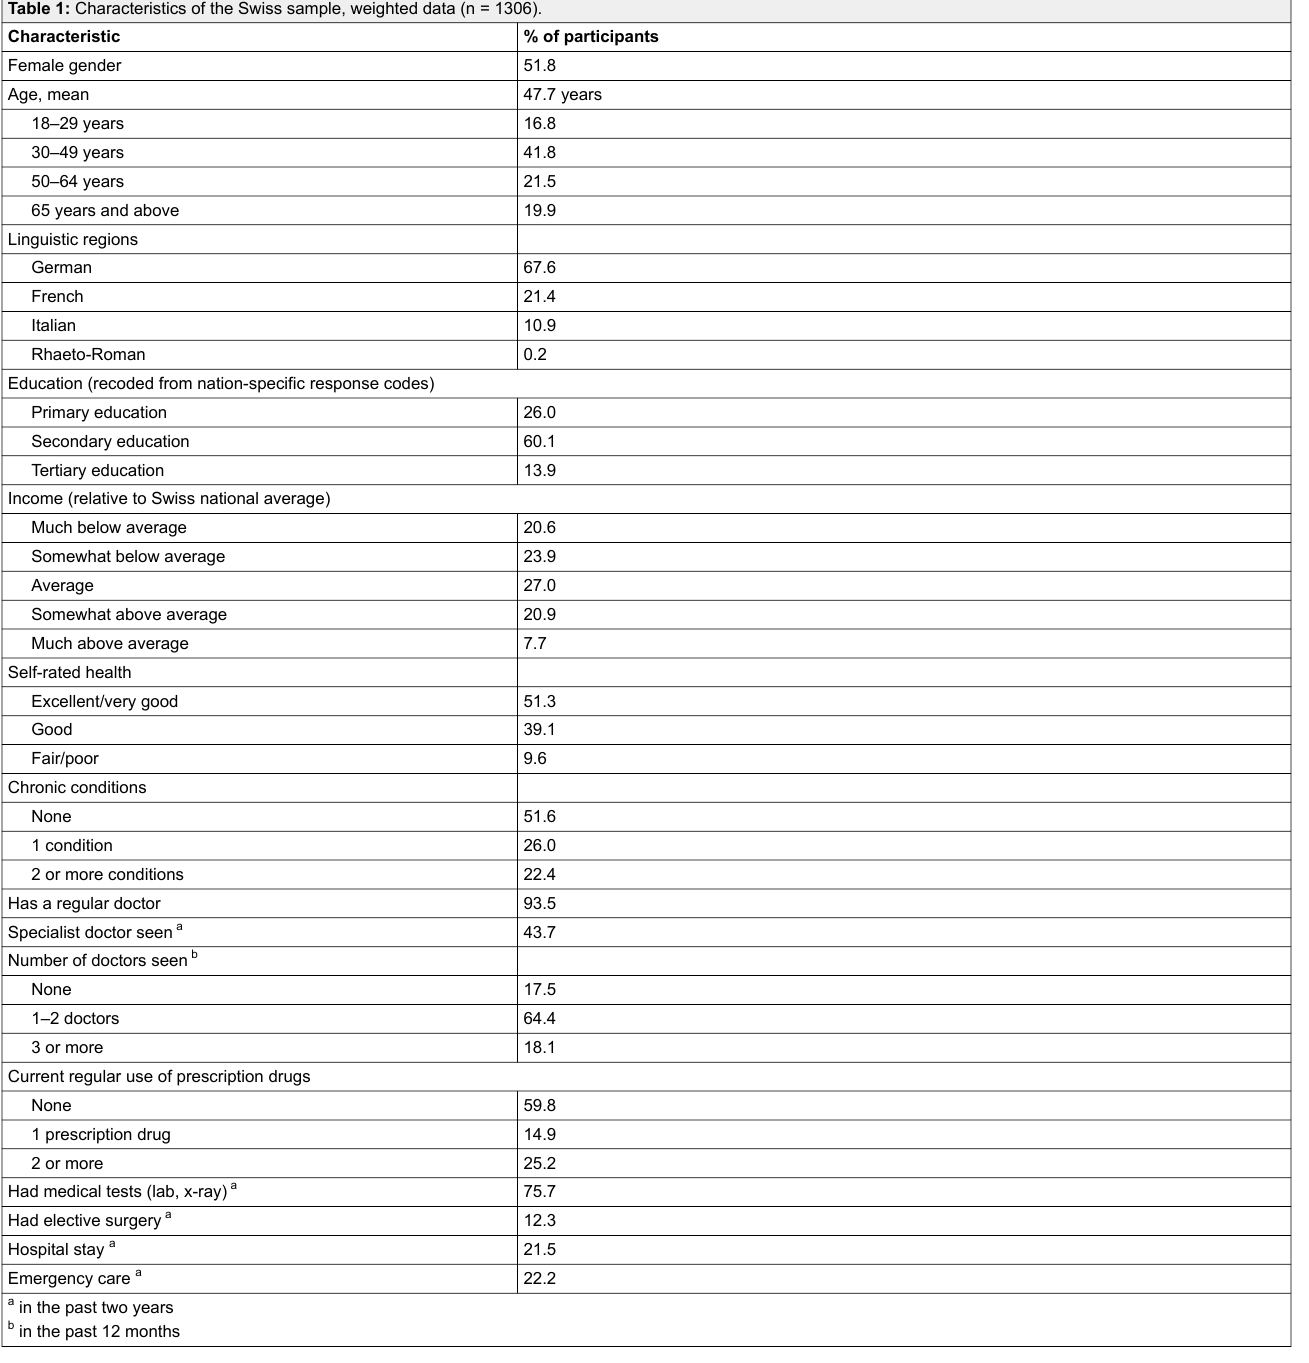
Table 1: Characteristics of the Swiss sample, weighted data (n = 1306).